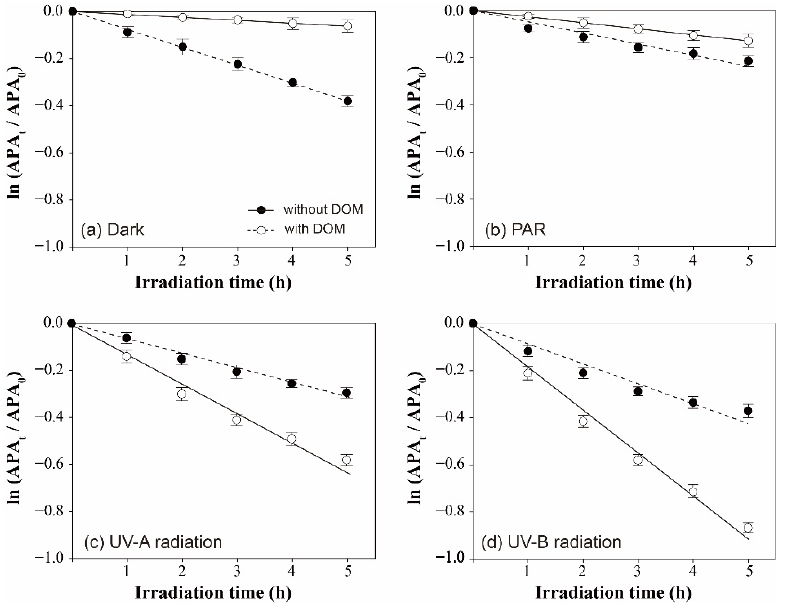
Figure 8. Effects of irradiation and DOM on the inactivation of M. aeruginosa -derived APase: ( a ) dark, ( b ) PAR, ( c ) UV-A radiation and ( d ) UV-B radiation.